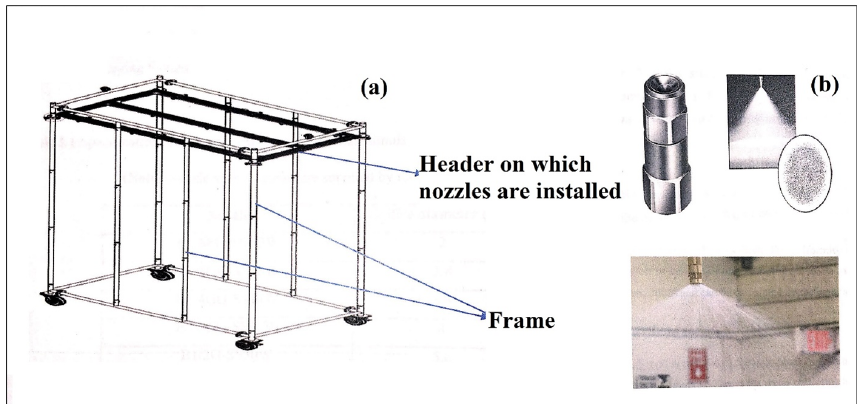
Figure 1. (a) Schematic diagram of RS. (b) Spraying System Co. Full jet G-style Spray Nozzle and Nozzle Spray flume. Source: Spraying System Co. Pvt Ltd, Bangalore.